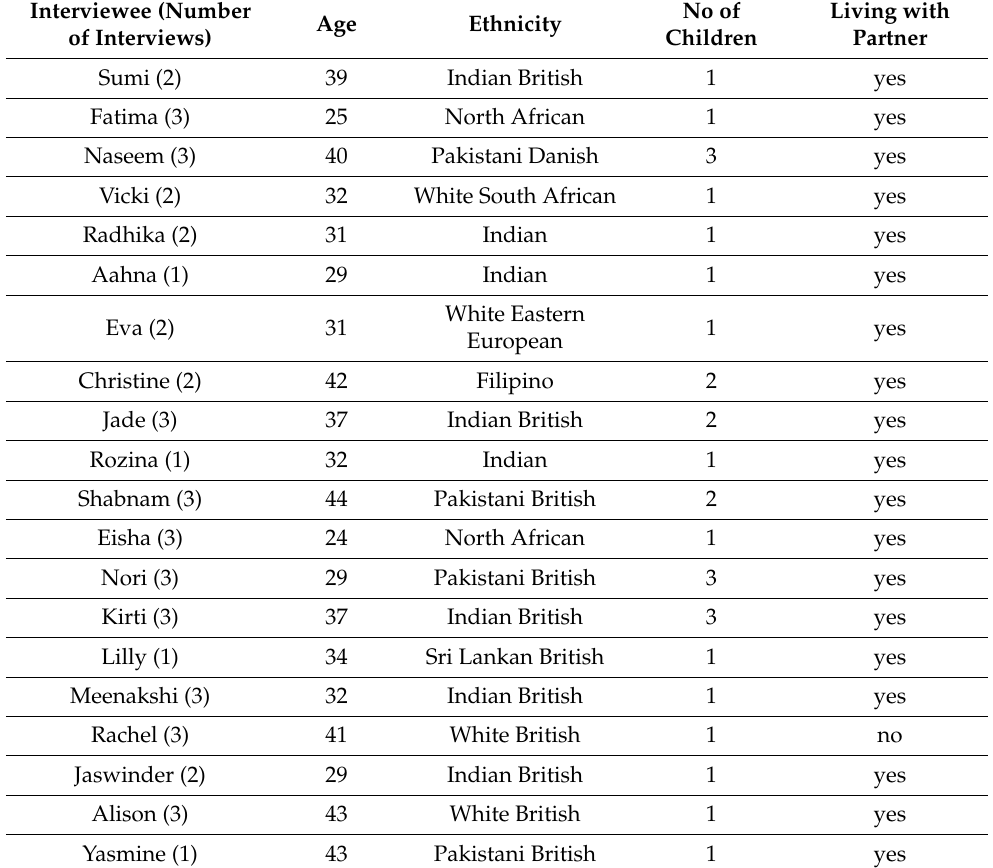
Table 1. Participant